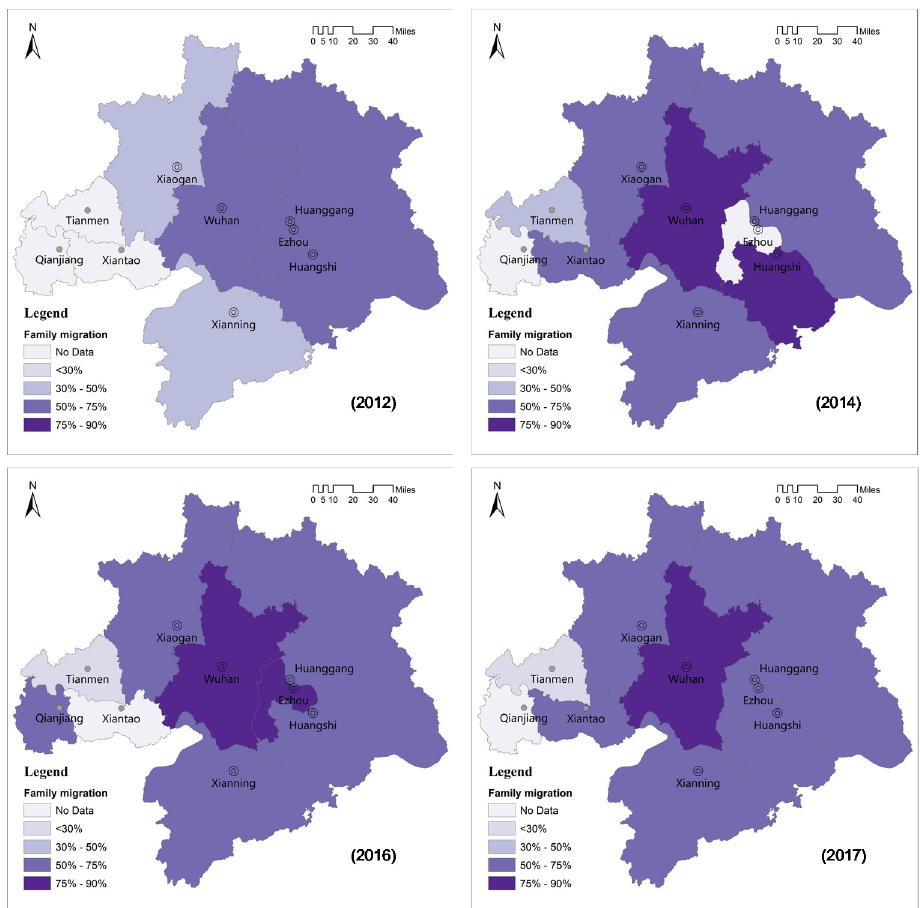
Figure 5. Spatial distribution of family migration in the Wuhan urban agglomeration (years 2012, 2014, 2016, and 2017).